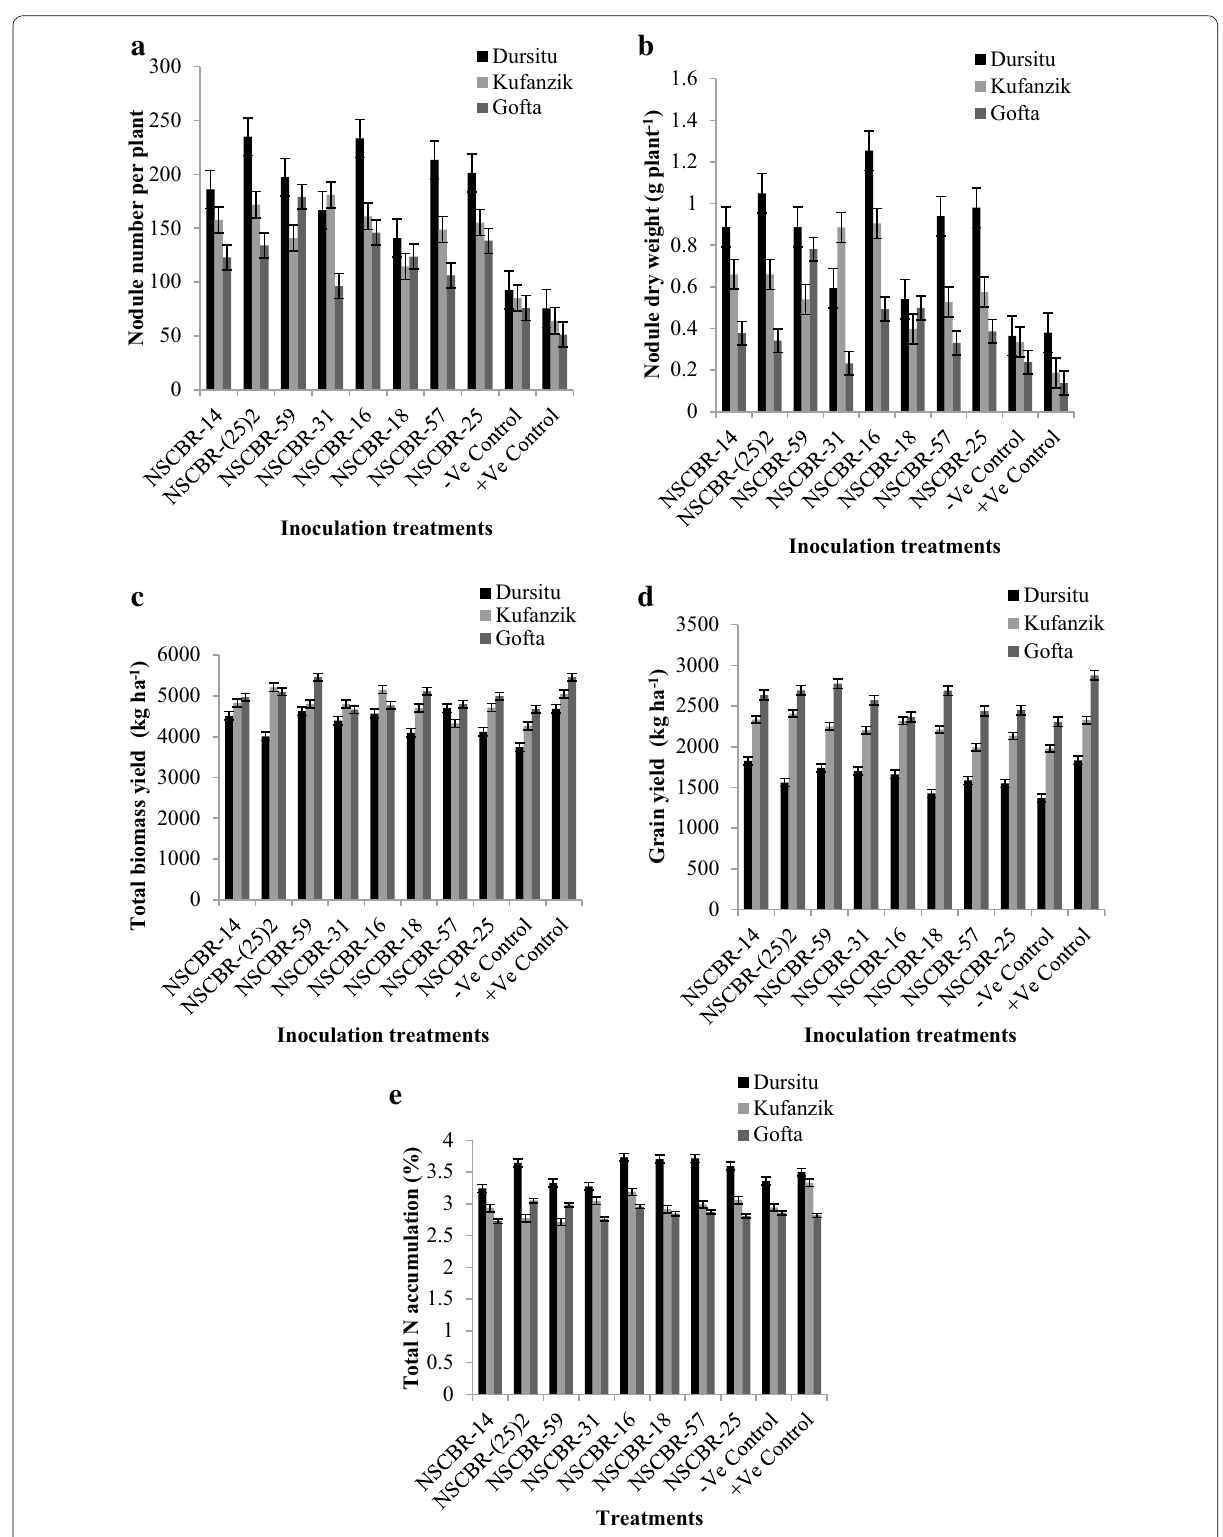
Fig. 1 The effect of Rhizobium isolates inoculation on a Nodule number, b Nodule dry weight, c Total biomass yield, d Grain yield and e Total N accumulation of three varieties of common bean, in eastern Ethiopia, 2012/2013 cropping